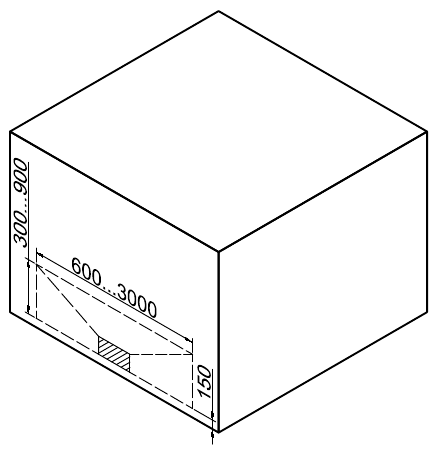
Figure 4. Radiators